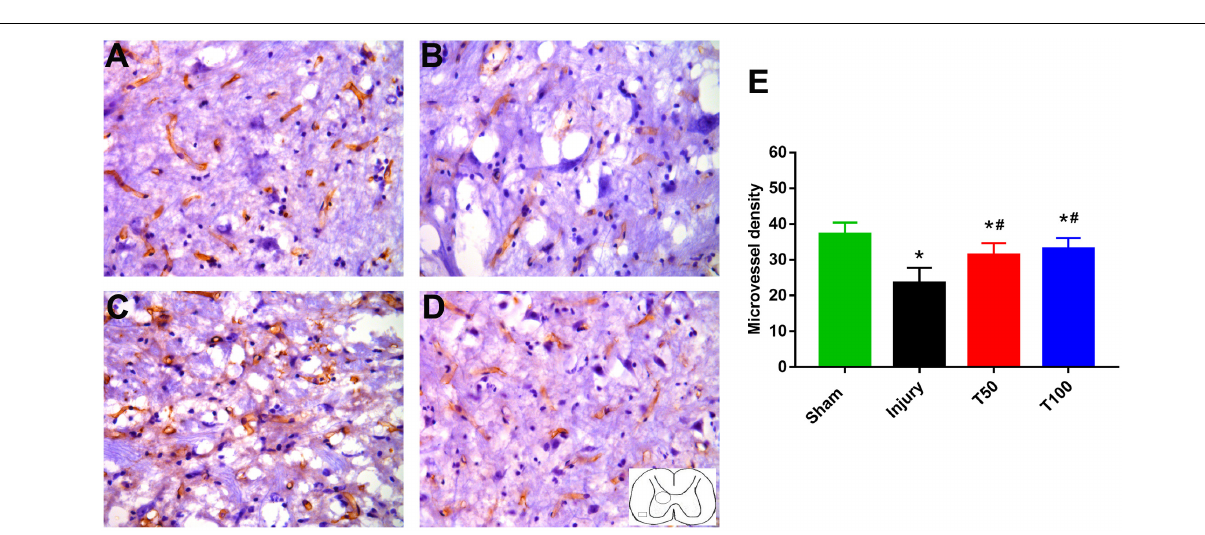
FIGURE 8 | CD34 immunohistochemical staining. (A) Sham group; (B) injury group; (C) T50 group; (D) T100 group; (E) statistical results of microvascular density showed that MVD of injury group, T50 group and T100 group were significantly lower than Sham group, and the MVD of T50 group and T100 group were significantly higher than injury group. * P < 0.05, comparison between each group and sham group; # P < 0.05, comparison between T50 group or T100 group and injury